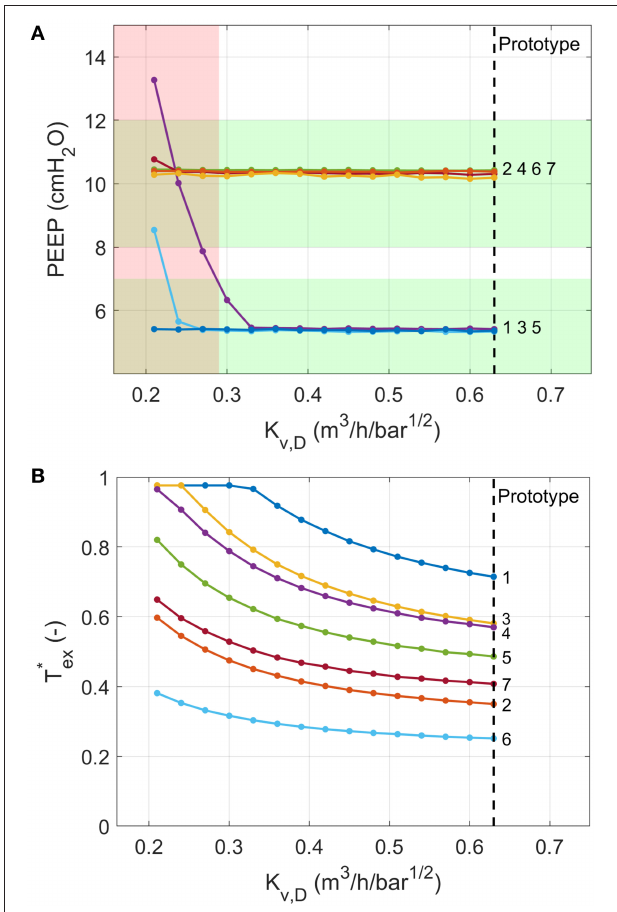
FIGURE 13 | Numerical model predictions of the variation in (A) PEEP and (B) the fraction of exhalation time required to reach PEEP for different values of the flow coefficient of Valve D. Ventilation conditions are labelled by their numbers according to the ISO 80601-2-12:2020 test requirements ( Table 2 ). The red shading indicates a failure in at least one of the test cases (PEEP more than 2 cmH 2 O away from target), predicted for K v , D ≤ 0.29. Vertical dashed lines indicate flow coefficient of valve used in the